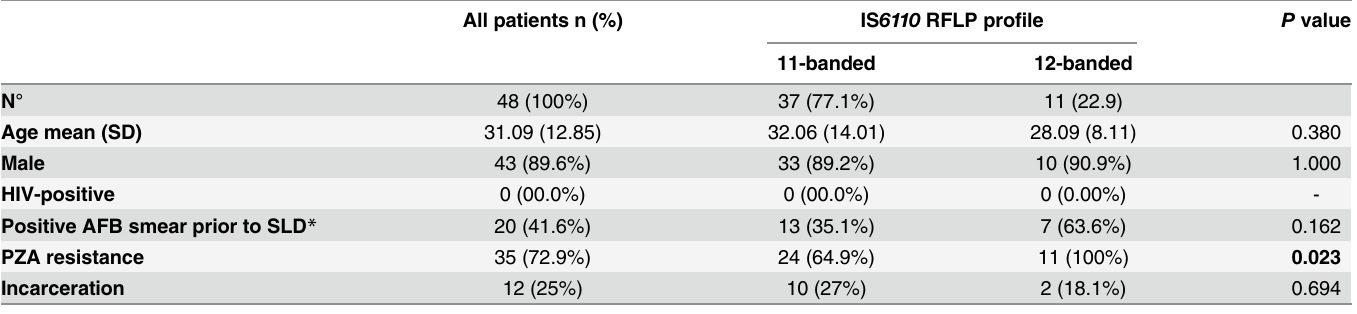
Table 1. Baseline demographic characteristics of the 48 MDR-TB outbreak-associated patients according to the IS 6110 -RFLP profile of their corre- sponding isolate.